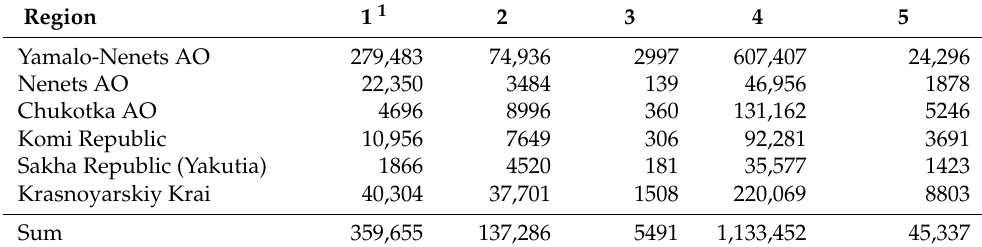
Table 6. The basic calculations for assessing the effects on the construction